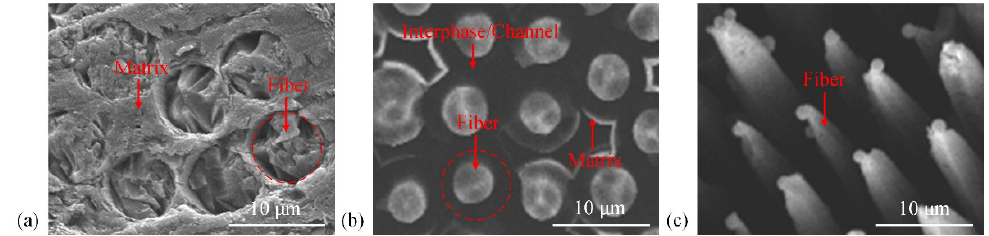
Figure 2. SEM images of carbon/carbon composite morphology: ( a ) before oxidation; ( b ) after oxidation at 1200 ◦ C in air for 8 min; ( c ) after oxidation at 1200 ◦ C in air for 15